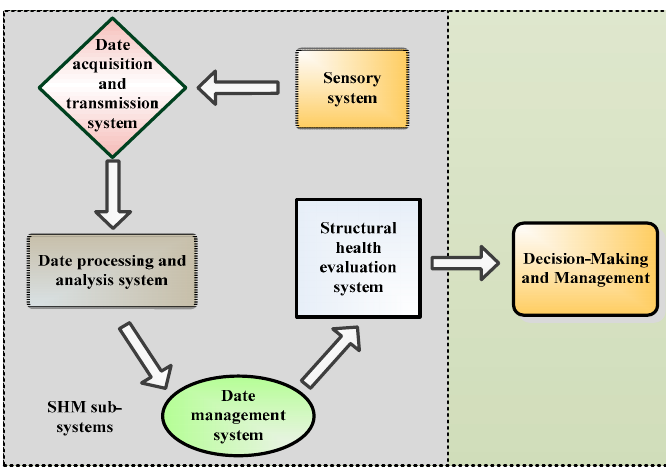
Figure 1. Subsystems of a long-term SHM system.